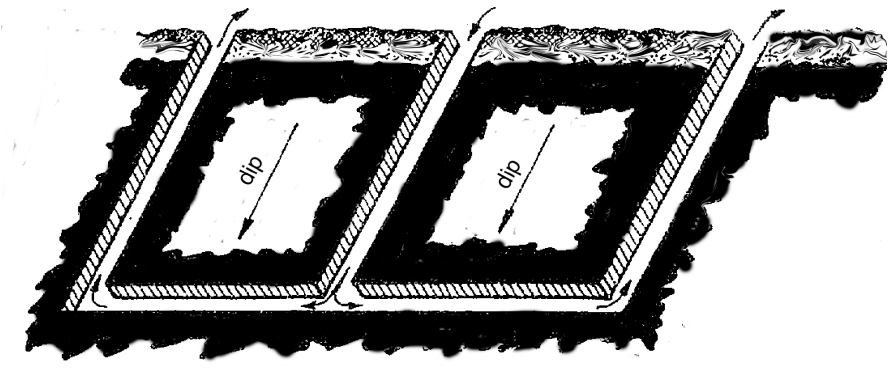
Figure 6. DUKhI stream gasification method for steeply dipping seams